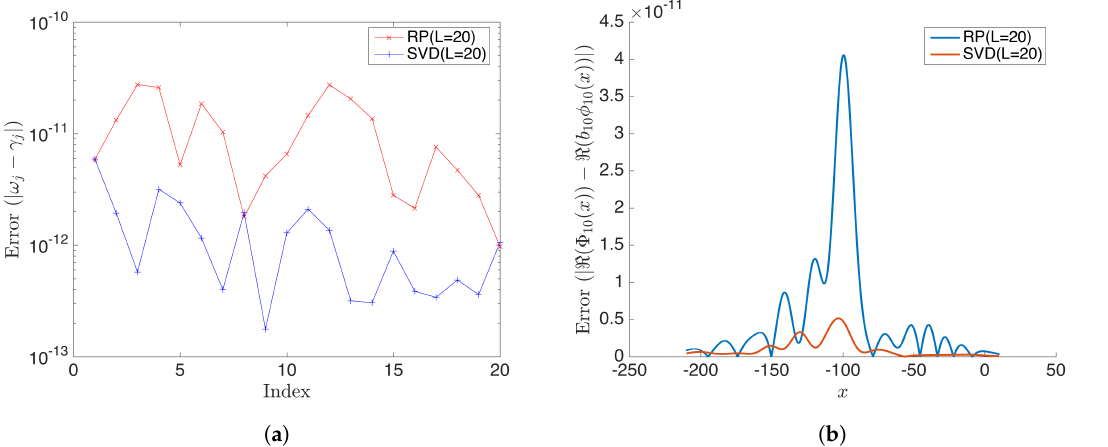
Figure 8. ( a ) Shows the absolute error for estimated eigenvalues from rDMD and the exact DMD when the dimension of the projected space L = 20. ( b ) Shows the absolute error for the estimated 10th DMD mode by rDMD and exact DMD methods. In this case, both methods have very accurate results and error is less than 10 − 10